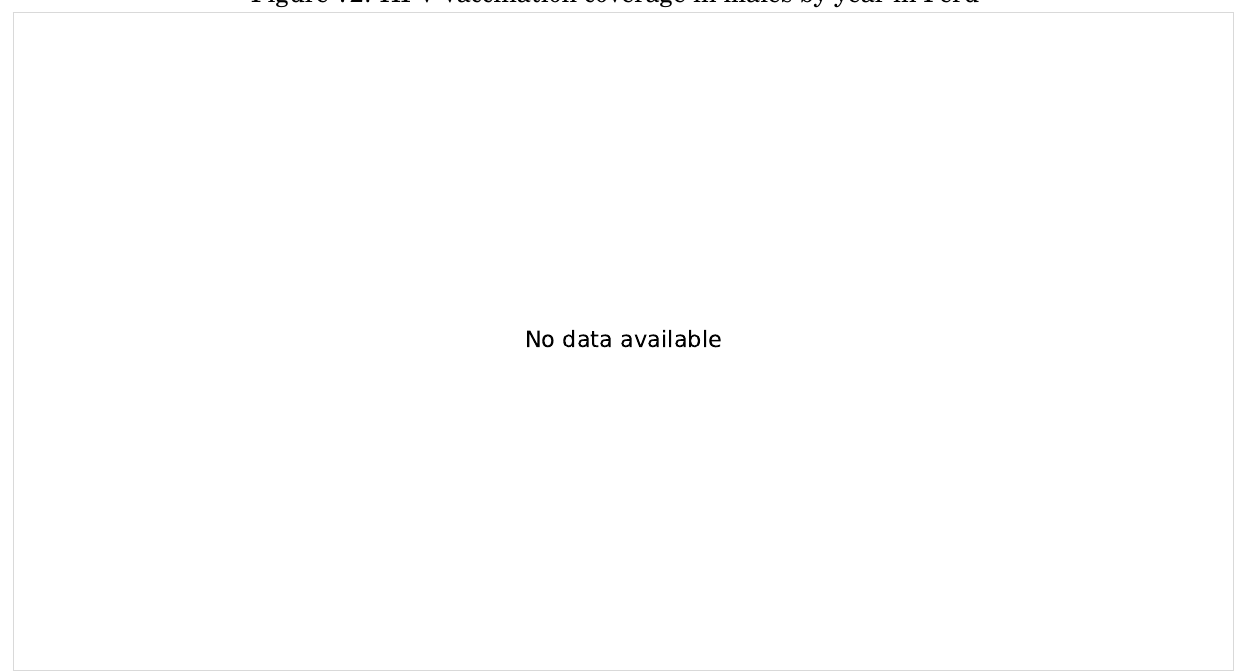
Figure 72: HPV vaccination coverage in males by year in Peru